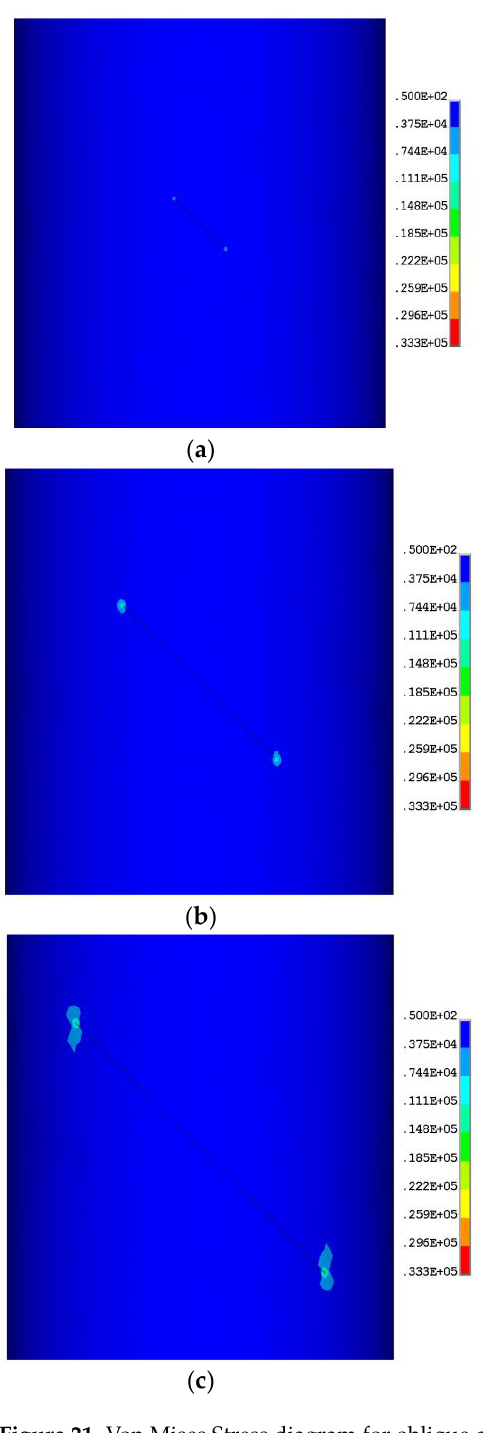
Figure 21. Von Mises Stress diagram for oblique cracks with different crack lengths (Pa). ( a ) Relative length coefficient ξ 2 = 0.05, ( b ) Relative length coefficient ξ 2 = 0.15, ( c ) Relative length coefficient ξ 2 = 0 . 25 . Taking the inclination angles o o o o 75 , 60 , 45 , 30 = and tension σ = 1200 Pa , 0.2 = tributions of the cracks with different inclination angles on the components. The colour scale represents Von Mises Stress. The aim is comparing stress fields for different oblique angles.